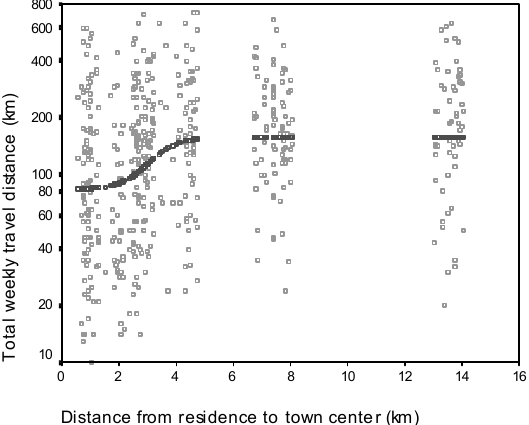
Figure 10. Total weekly travel distance (km) among respondents living at different distances from the centre of Frederikshavn